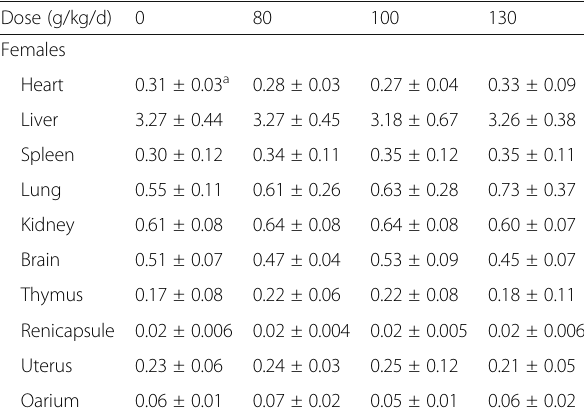
Table 11 Organ coefficient for female rats treated with JDHY granules for 13